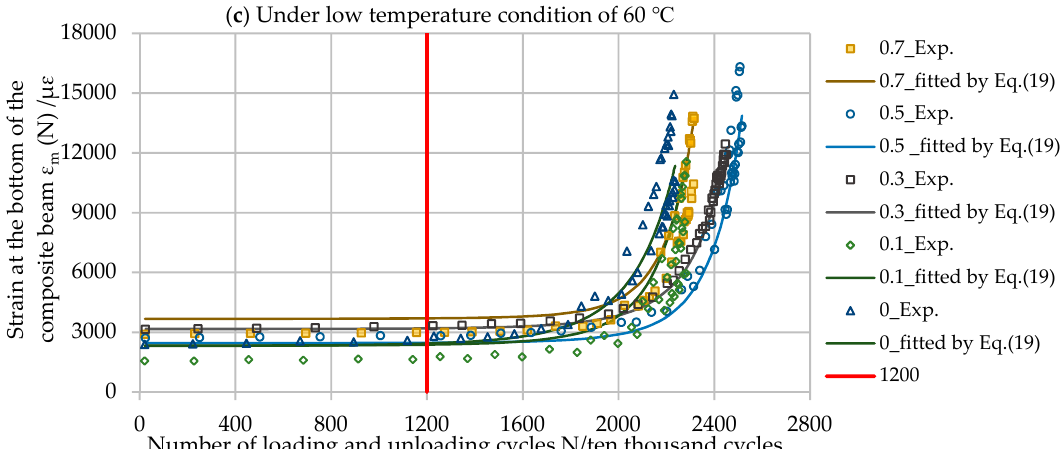
Figure 5. Relationships between the bottom edge strain ε cm ( N ) and fatigue load cycles N under different ambient temperatures and with fiber volume ratios of 0%, 0.1%, 0.3%, 0.5%, and 0.7%: ( a ) under high-temperature conditions, 60 °C; ( b ) under normal temperature condition, 20 °C; ( c ) under low-temperature conditions, − 15°C. Note: The red line represents “1200/10,000 cycles,” which is the design standard for steel deck AC surfacing [47].